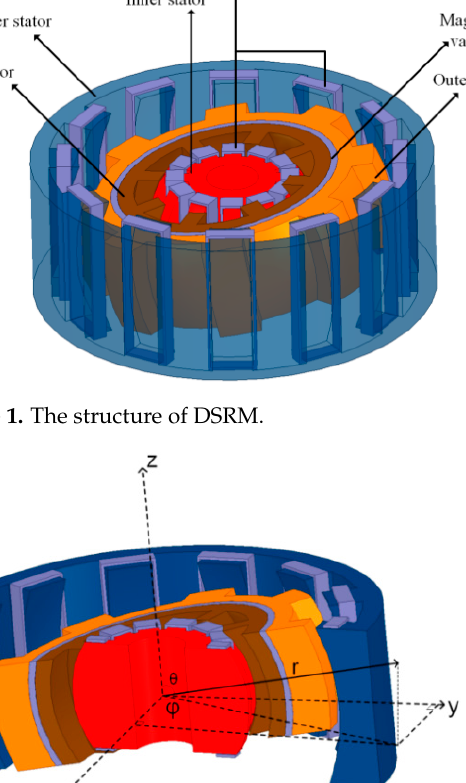
Figure 1. The structure of DSRM.